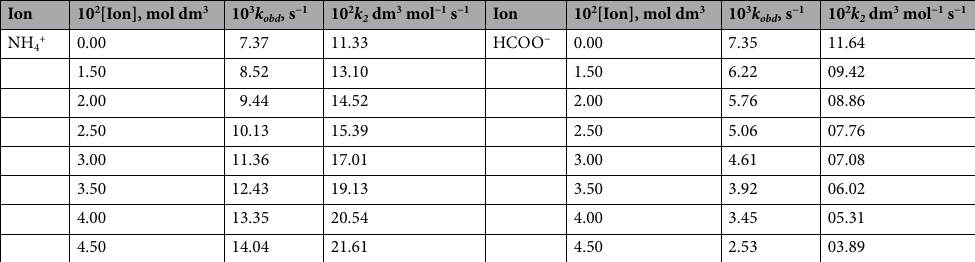
Table 3. Effect of counterions on the reaction rate for the reduction of [Mo IV O 2 (paoH) 2 ] 2− by S 2 O 42− .